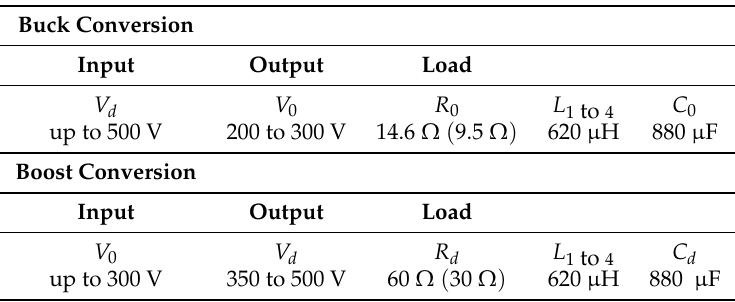
Figure 8. Experimental setup; ( a ) interleaving DC–DC buck and boost converter; ( b ) FPGA board; ( c ) half-bridge module. Table 1. Simulation and experimental